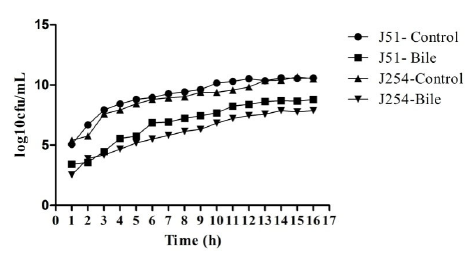
Figure 2. Growth kinetics of the isolates (J51 and J254) under control and bile (3%) conditions. Unpaired t ‐ test was performed and p < 0.05 was considered significant. 3.5. Variation in Minimum Inhibitory Concentration (MIC) on Exposure to In ‐ Vitro Gut Conditions The majority of the in vitro gut conditions did not have any effect on MIC levels for tested antibiotics in both the isolates. A slight variation in MIC level (from 8 μ g/ml to 12 μ g/ml) for nitrofurantoin was observed in J51 for in vitro gut conditions, such as HI, bile, and NaCl, and in J254 for HI and bile. Similarly, variation in MIC level (from 0.094 μ g/ ml to 0.125 μ g/ml) for ciprofloxacin was observed in J254 for HI, bile and LT conditions ( Table S2 and S3 ) .